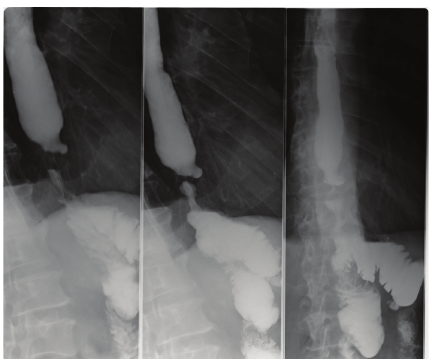
Figure 5: Moderate distal esophageal stenosis before the third stent placement.